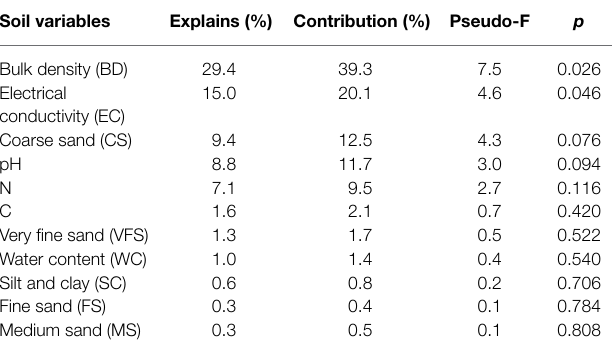
TABLE 1 | Contribution of soil properties to variation of leaf traits of S. glareosa